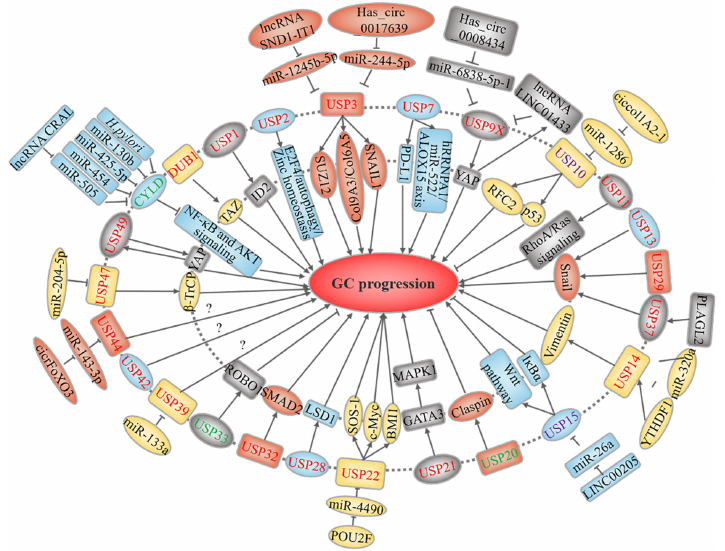
Figure 2. USP-related upstream regulation and downstream mechanisms in GC. USPs marked in red and green represent oncoproteins and tumor suppressors, respectively, while purple-labeled USPs play a dual role. The text in the outer and inner circles of the USPs describes the upstream regulatory events and downstream substrates or signaling pathways, respectively.